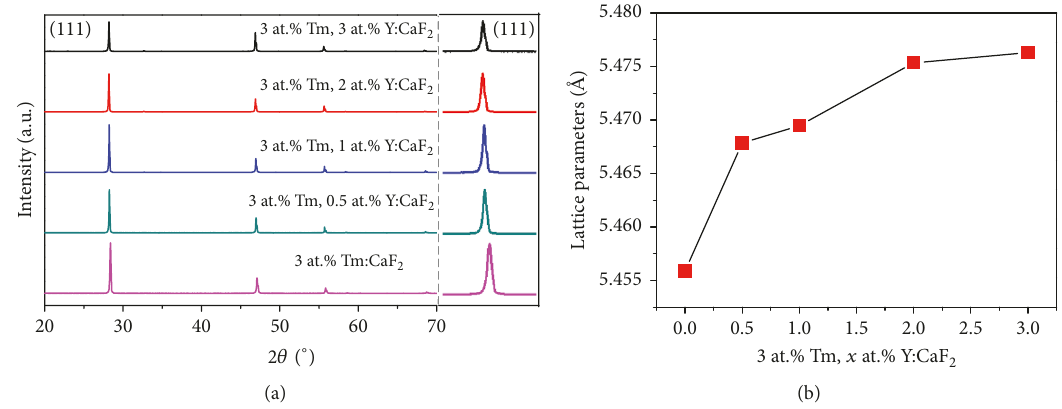
Figure 1: The XRD patterns (a) and lattice parameters (b) of 3 at.% Tm, 𝑥 at.% Y:CaF 2